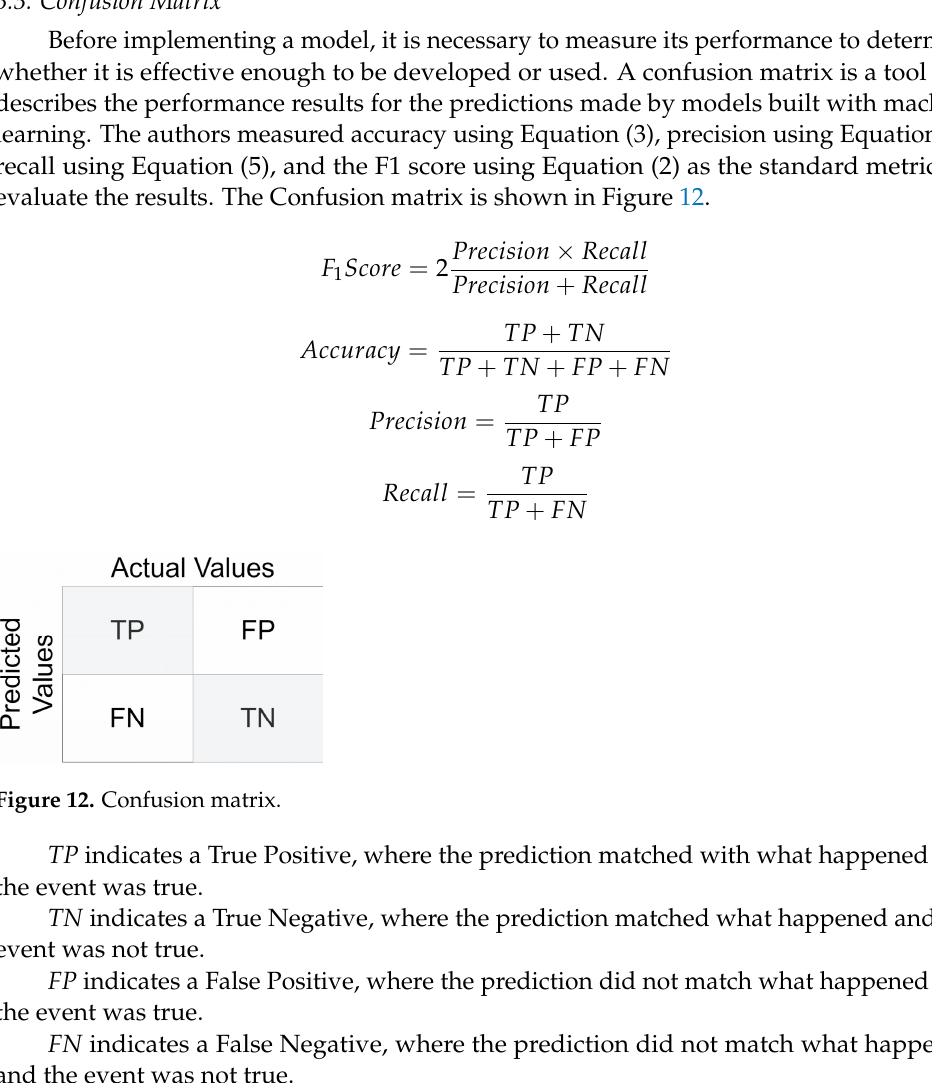
Table 4. CNN parameters used in training.